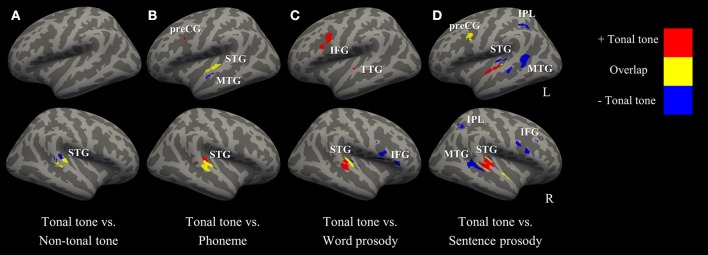
Conjunction and contrast maps between tonal tone and other conditions (uncorrected p < 0.001, minimum cluster = 100 mm3). (A–D) comparisons of tonal tone with non-tonal tone, phoneme, word prosody, and sentence prosody, respectively. Red: regions uniquely recruited in tonal tone compared with one of the other conditions; yellow: regions coactivated in tonal tone and one of the other conditions; blue: regions specifically engaged in one of the other conditions compared with tonal tone. IFG, inferior frontal gyrus; IPL, inferior parietal lobule; MTG, middle temporal gyrus; preCG, precentral gyrus; STG, superior temporal gyrus; TTG, transverse temporal gyrus.